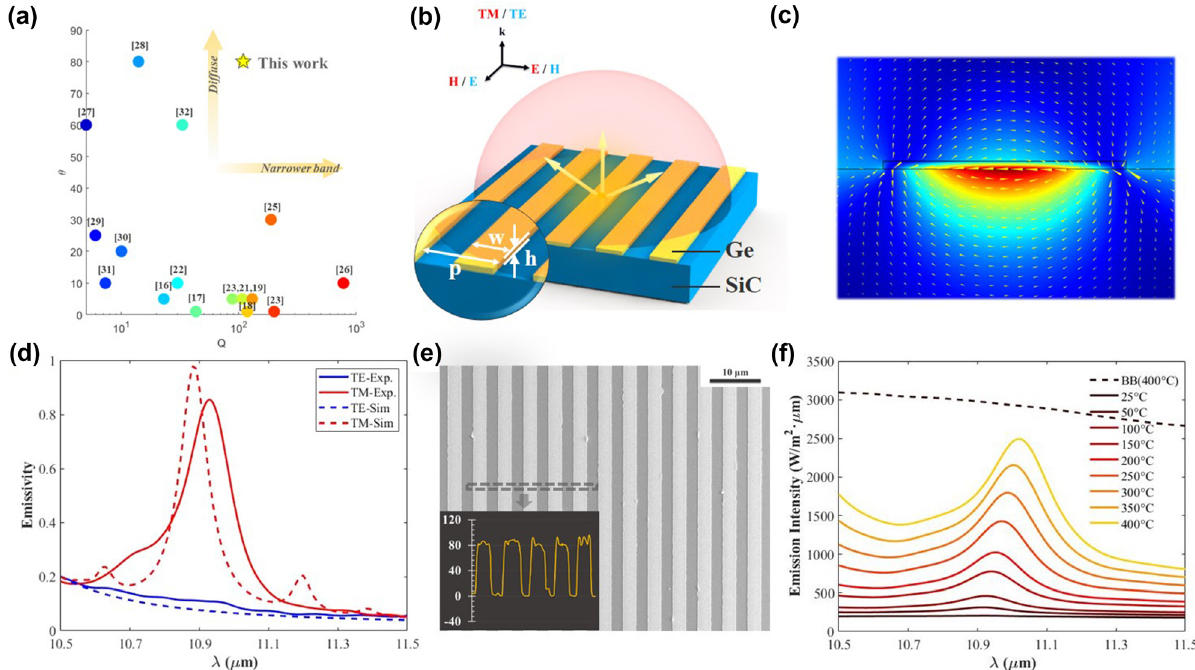
Figure 1: Narrowband diffuse thermal emitter based on phonon-mediated nanostructures. (a) Comparison with reported thermal emitters in terms of spectral and spatial characteristics. (b) Schematic illustration of the designed phonon-mediated nanostructures. (c) Magnetic field distribution of the phonon-mediated nanostructures. The yellow arrows indicate the direction of displacement current. (d) Simulated (dotted curves) and experimental (solid curves) emissivity spectra of the phonon-mediated nanostructure with polarized light. The red curves represent emission under TM polarization and the blue ones under TE polarization. (e) Scanning electron microscopy image of the phonon- mediated nanostructure. (Inset: height-scanning results.) (f) The emission intensity of the phonon-mediated nanostructure under different heating temperatures. The dotted black curve represents the emission intensity of the blackbody under 400 °